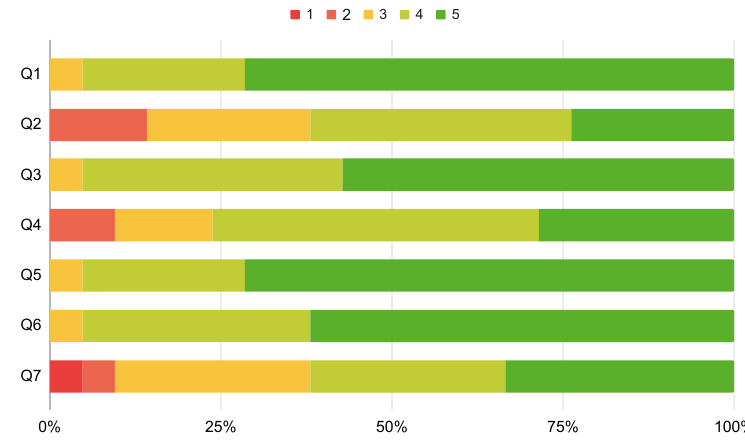
Figure 17. Responses to questions Q1–Q7 . Likert scale from 1 (strongly disagree) to 5 (strongly agree).